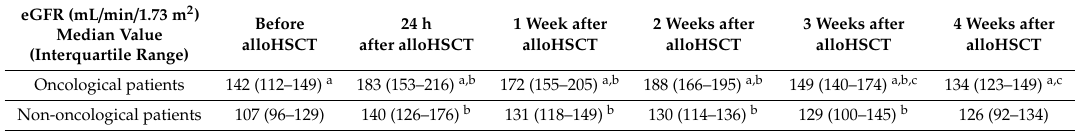
Table 1. eGFR values in examined